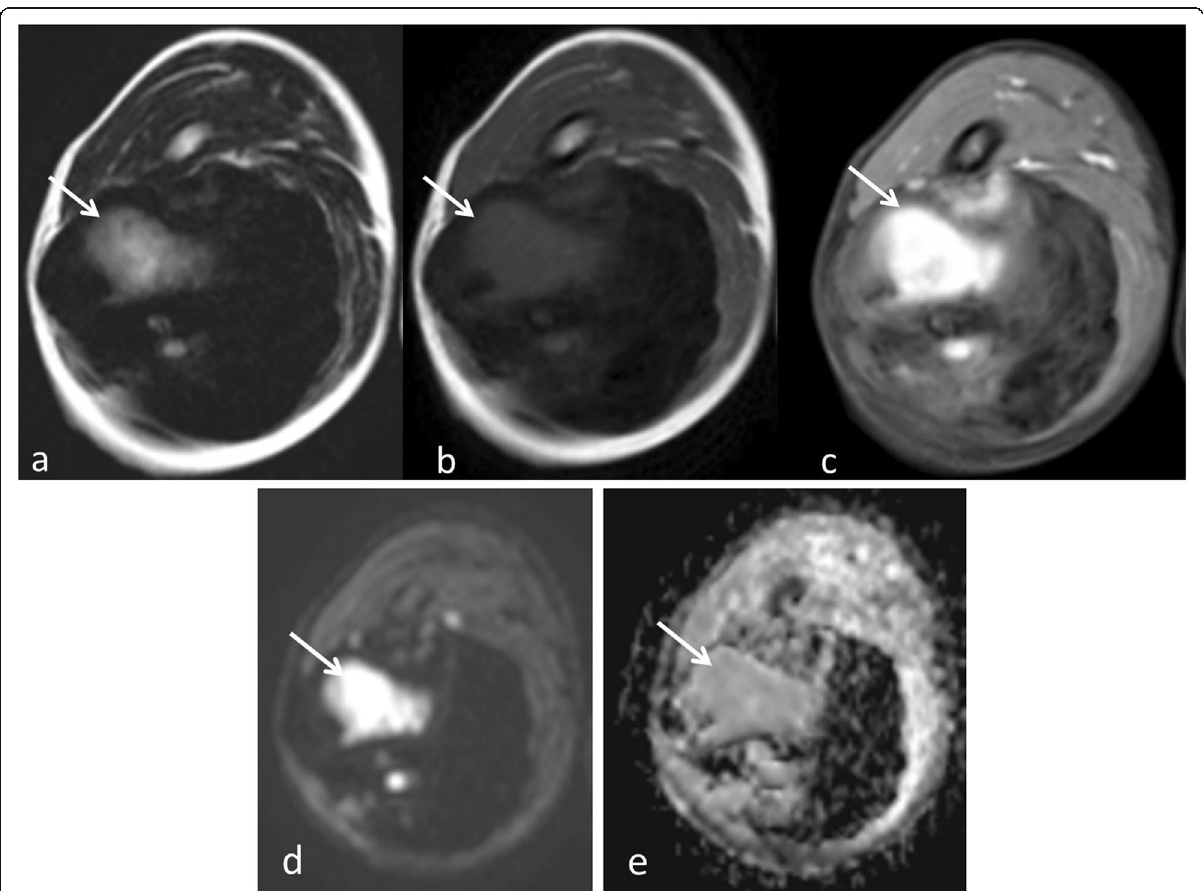
Fig. 1 Right thigh fibromatosis presenting in a 9-year-old male; a axial T2, b axial T1, c axial post-contrast THRIVE, d DWI, and e ADC images showing characteristic signal pattern. The central part of the lesion (arrow in a , b , c , d , and e ) showed high T2 signal, low T1 signal, and marked contrast enhancement representing the more cellular part of the lesion and also exhibited high signal on the DWI, intermediate signal on the ADC images denoting restricted diffusion. Note the periphery of the lesion showed persistent low signal area along the T2, DWI, and ADC images and no contrast uptake on the post-contrast THRIVE, representing the predominance of collagen in this area